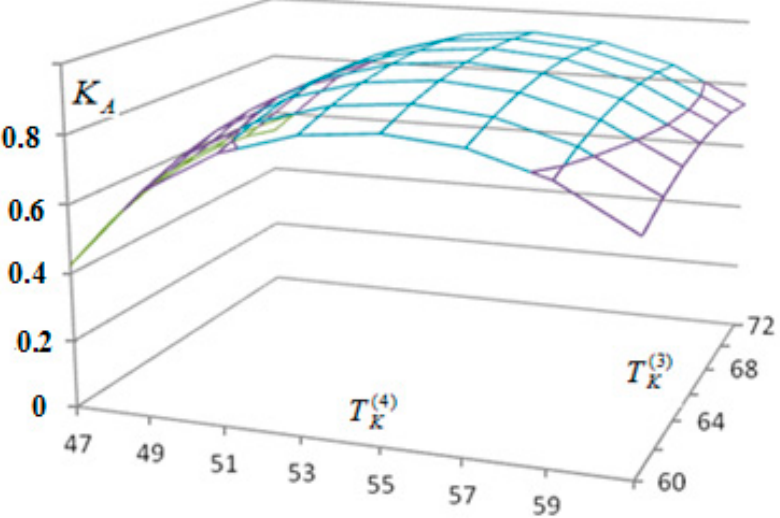
Figure 9. Dependence of the readiness coefficient K A on the TIBV for technical conditions E 3 and E 4 . The calculations have shown that the maximum value of the readiness coefficient is achieved if the TIBV for the fourth degradation group is about 1.3 times less than for the third